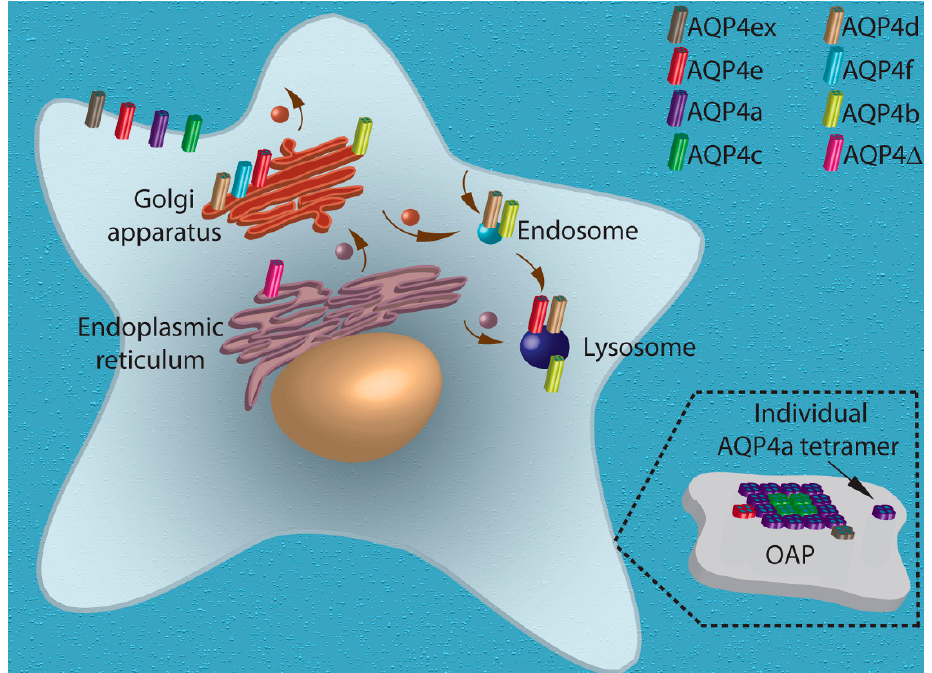
Figure 1. Cellular distribution of known AQP4 isoforms in astrocytes. Nine AQP4 isoforms have been identified in astrocytes: a (M1), b, c (M23), d, e, f in rat astrocytes and a (My1), c (M23), ex (note that both AQP4a and AQP4c are also expressed in the extended form) and ∆ 4 in human astrocytes. AQP4 isoforms a, c, and ex were detected at the plasma membrane, e was detected at the plasma membrane and in intracellular compartments, and other isoforms are solely intracellular, co-localizing with the Golgi apparatus (b, d, f), endoplasmic reticulum ( ∆ 4), early endosomes (b, d), and lysosomes (b, d). Plasma membrane isoforms aggregate in OAPs. A patch of the plasma membrane containing OAPs and an individual AQP4a tetramer is enlarged in the dotted section. The core isoform in OAPs is isoform c (M23), isoform a (M1) assembles into OAPs through interlinking to c (M23). OAP localization of isoform e has been demonstrated in rat astrocytes and OAP localization of isoform ex has been demonstrated in human astrocytes. Isoform a (M1) is also present at the plasma membrane as individual tetramers, as depicted in the inset.